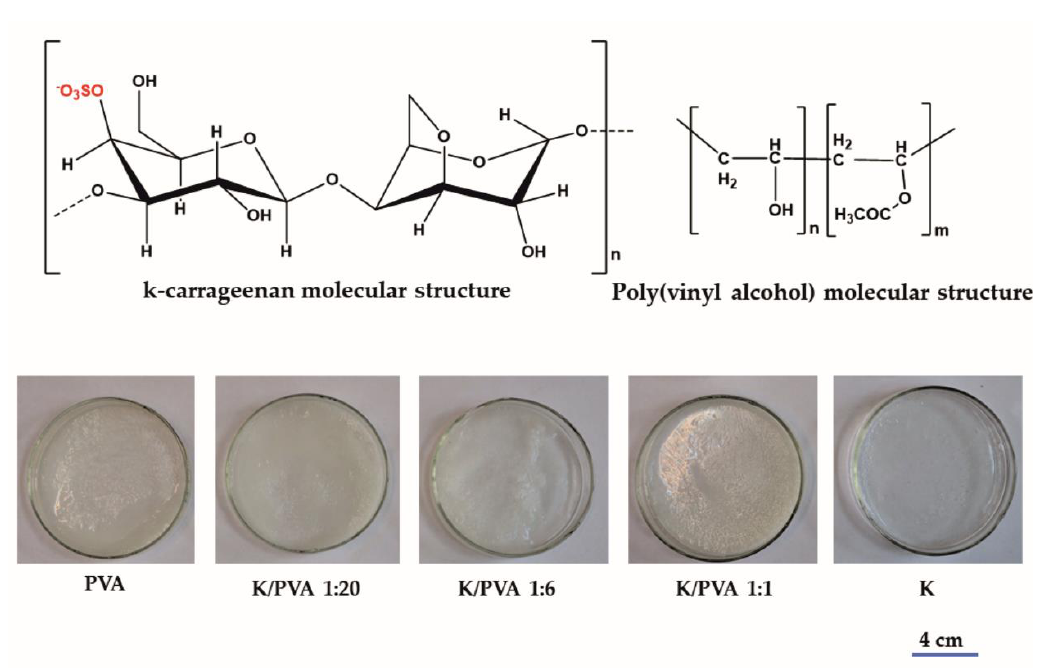
Figure 1. Molecular structure of the polymers and the photographic images of the obtained hydrogels.